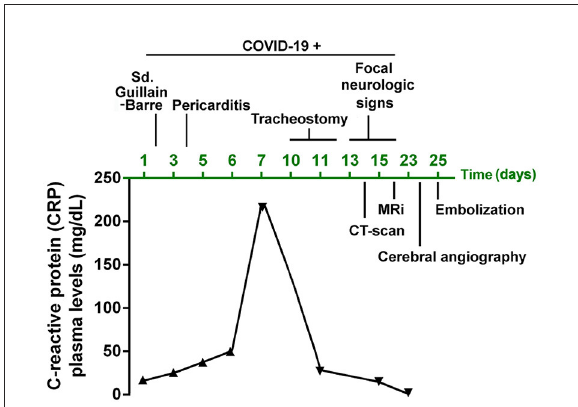
FIGURE1 Timeline of the case report scheme summarizing the disease, complications and progression of the patient. Study follow-up of the C-reactive protein (CRP) plasma